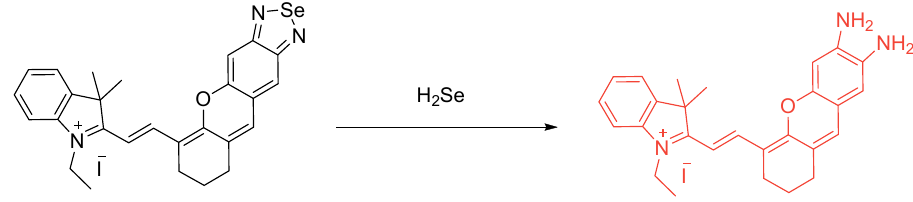
Figure 55. H 2 Se probe NIR–H 2 Se by Kong et al. involving the benzene selenodiazole unit.